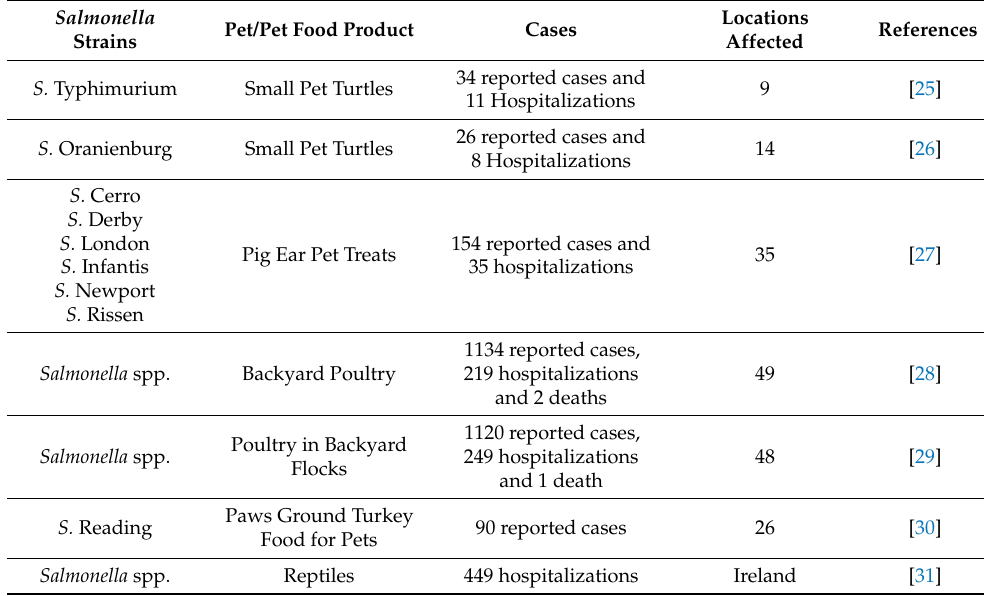
Table 2. Salmonella outbreaks involving pets/pet